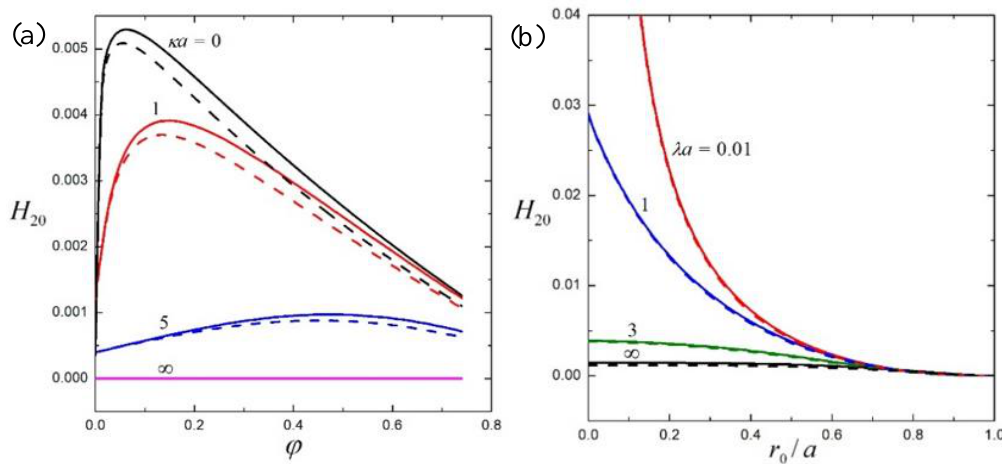
Figure 9. The chemiphoretic mobility coe ffi cient H 20 for a suspension of soft spheres: ( a ) λ a = 1 and r 0 / a = 0.5; ( b ) κ a = 1 and ϕ = 0.1. The solid and dashed curves represent the calculations for the Happel and Kuwabara models, respectively.